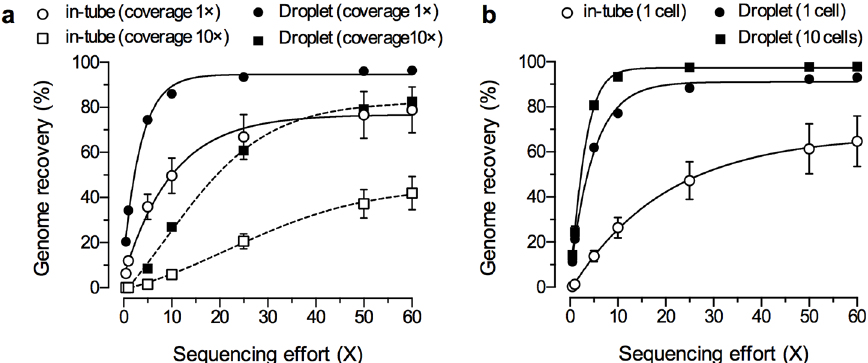
Fig 5. Genome recovery from row sequence reads and de novo assembled contigs obtained from droplet MDA products of single and 10 E . coli cells. (a) Comparison of genome recovery from raw sequence reads as a function of sequencing effort. Each plot shows the averaged percentage of genome recovery with SD from raw sequence reads for single (n = 3) and 10 (n = 3) Escherichia coli cells at > 1× or > 10× sequencing coverage. (b) Comparison of genome recovery from de novo assembled contigs as a function of sequencing effort. Each plot shows de novo assembly result in in-tube MDA and the droplet